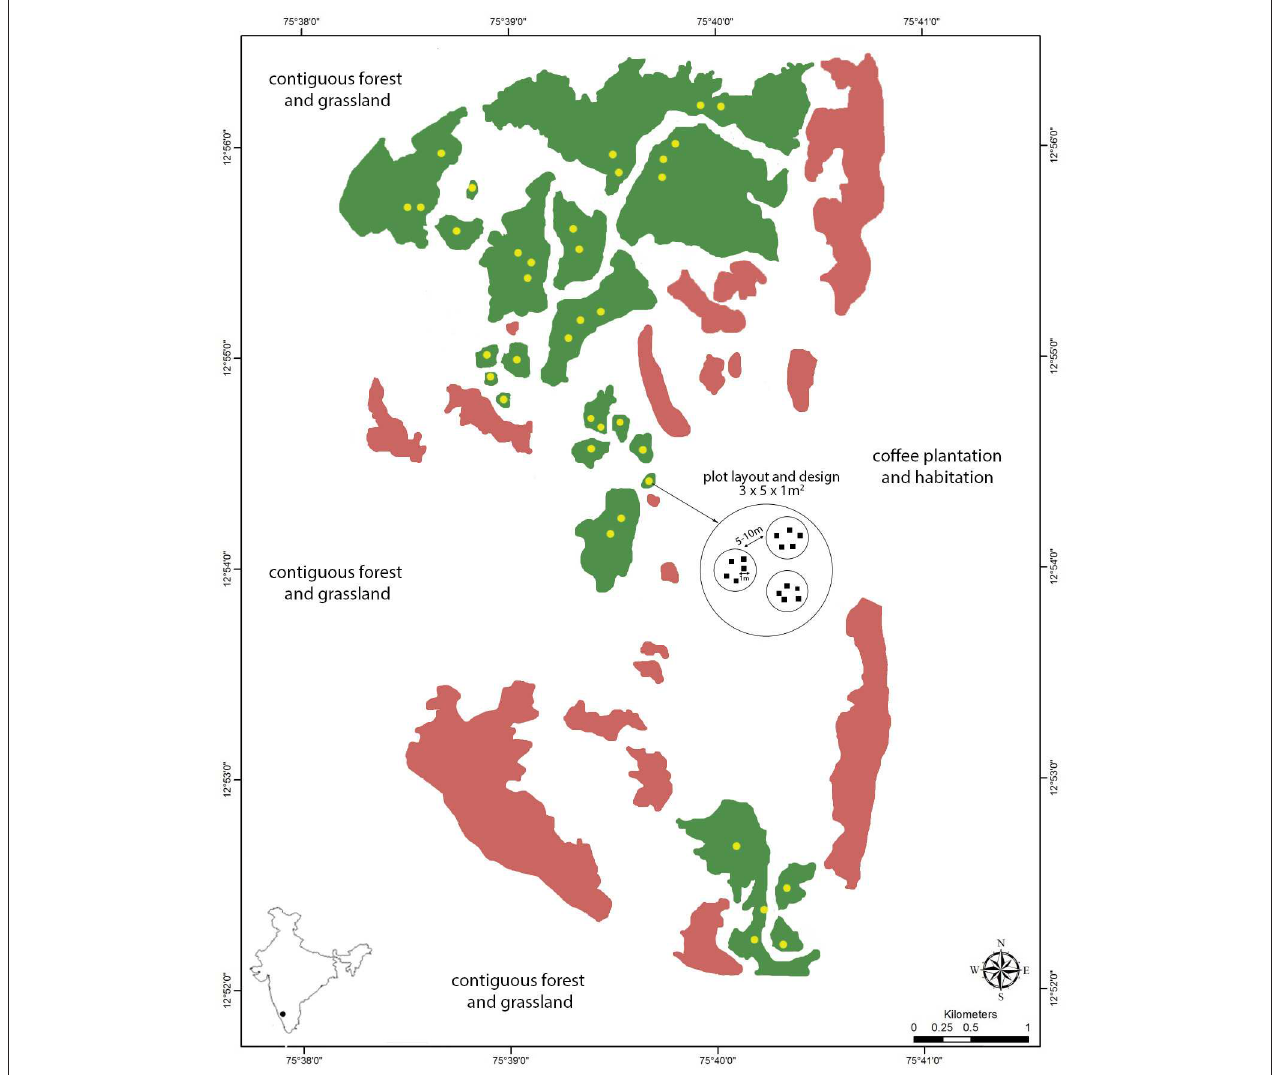
FIGURE 1 | Map of the study site (Kadamane Estate) with focal fragments in green ( N = 21), other (unsampled) forest fragments within the study site in pink, plot locations in yellow ( N = 37), and the plot layout and design at each location ( N = 555 plots). The study site is flanked by contiguous forest and high-altitude grassland to the north, south and west, and by coffee plantations and habitation to the east, as indicated by the text on the